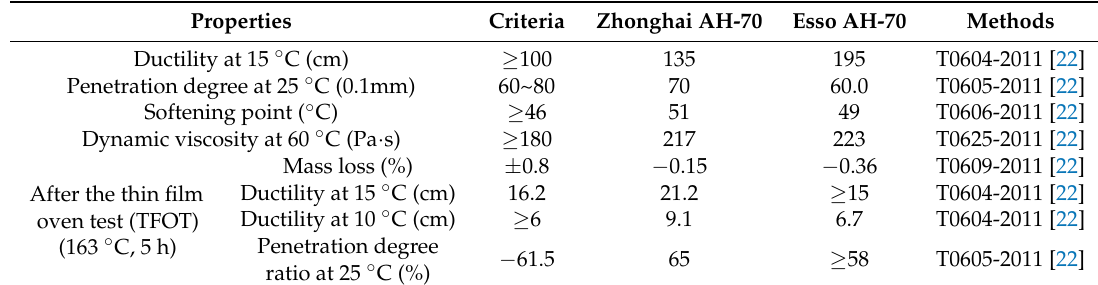
Table 2. Base asphalt properties.